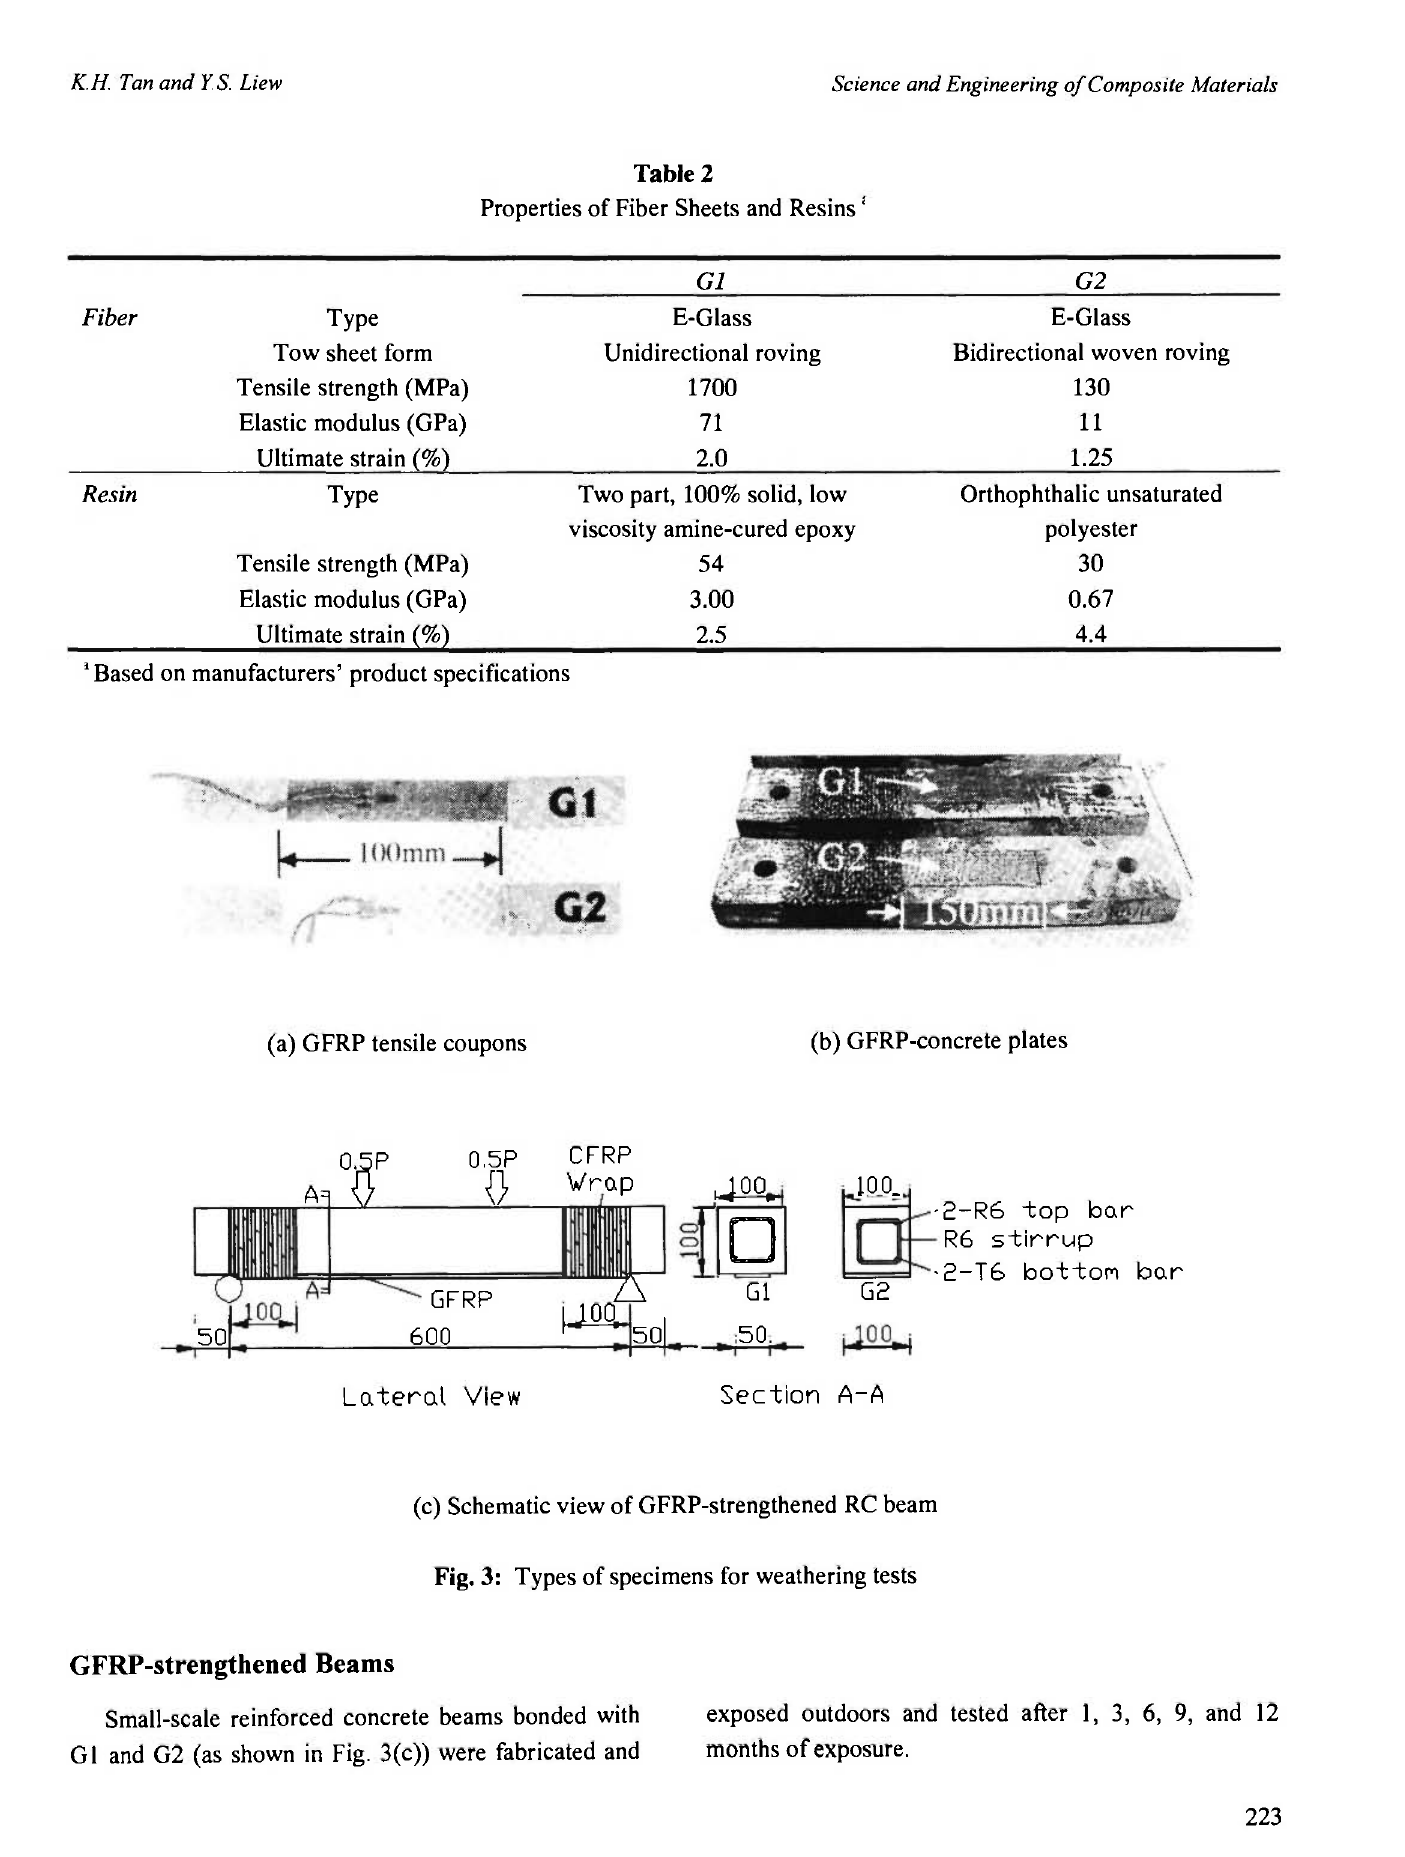
Fig. 3: Types of specimens for weathering tests